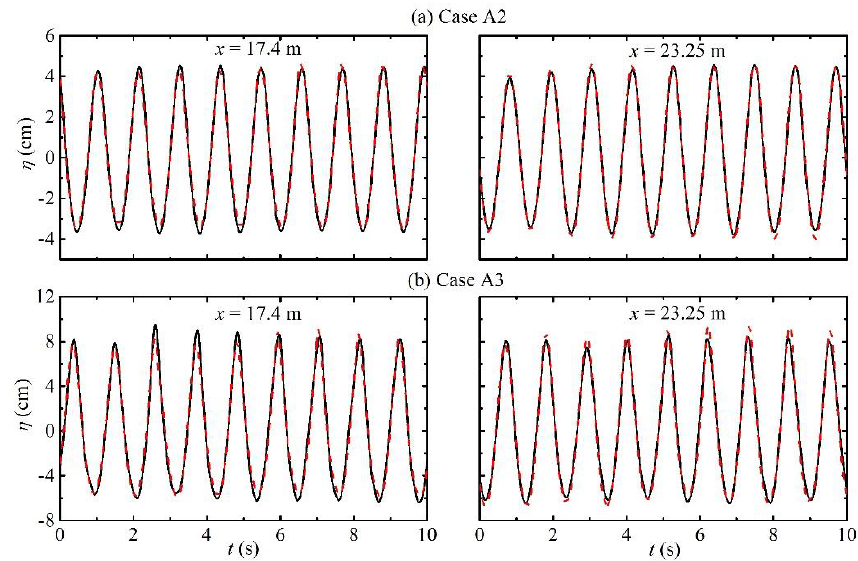
Figure 6. Surface profiles downstream of the interaction region for the regular wave train with f = 0.8 Hz in the B flume. The black solid lines represent the surface elevations recorded at the right side of the B flume, and the red dash lines represent the surface elevations recorded at the left side of the B flume.